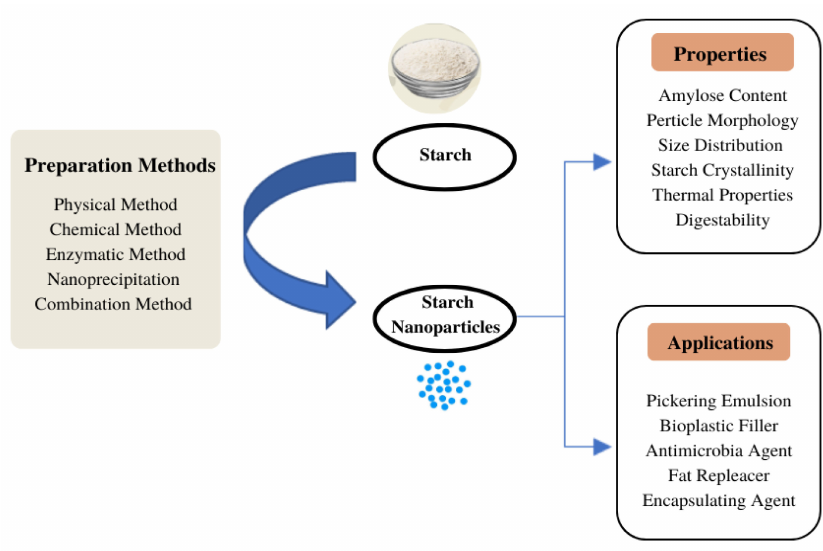
Figure 1. Scheme of SNP preparation, properties and